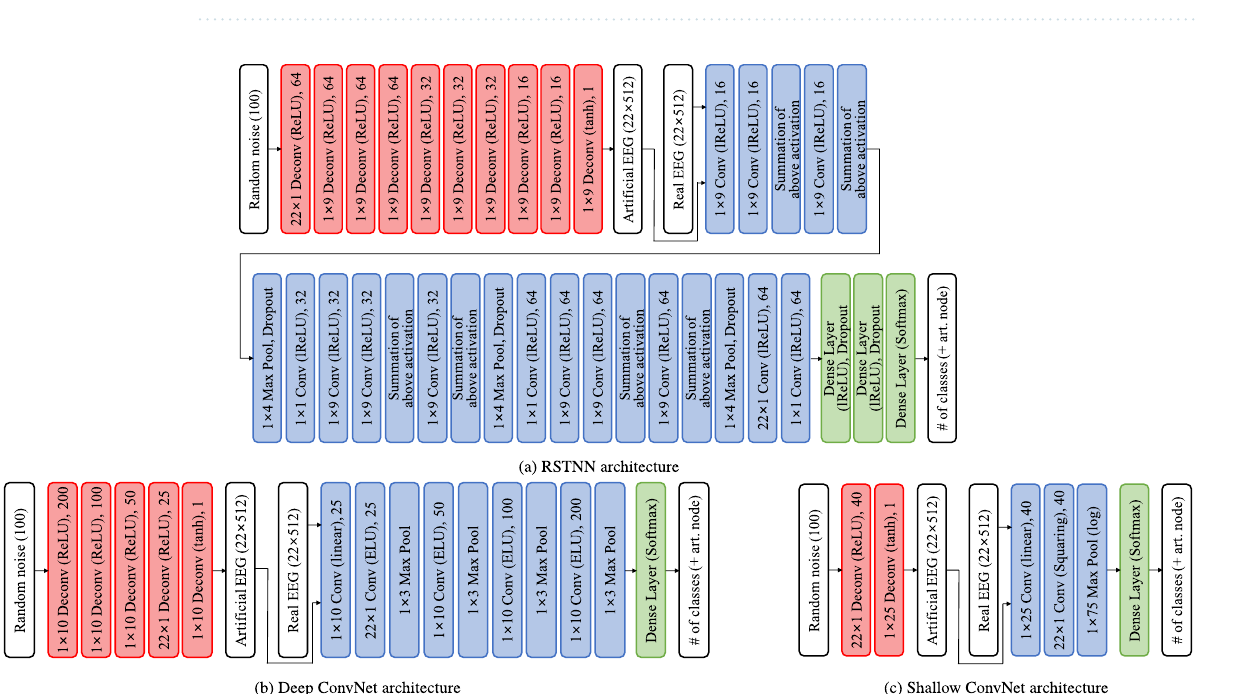
Figure 2. A schematic illustration of the proposed semi-supervised generative and discriminative deep adversarial learning framework for MI-based BCI. The black and red arrows denote data or features flows during a training step and a test step, respectively. (GDAL: generative and discriminative adversarial learning, SGDAL: semi-supervised GDAL).